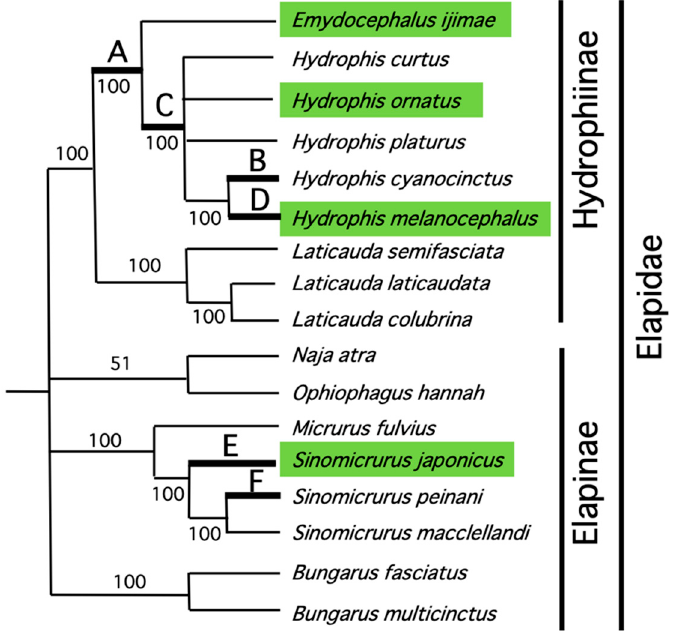
Figure 4. Timing of changes in mtDNA structural features in Elapidae. On a strict consensus tree between the ML trees constructed using nucleotide and amino acid sequences (see Figures S6 and S7, respectively), the ( A – F ) symbols indicate branches where changes in mtDNA features probably occurred as inferred by the maximum-parsimony criterion in change numbers. These changes are: ( A ), translocation of O L from between tRNA Asn and tRNA Cys genes to between tRNA Ala and tRNA Asn genes; ( B ), reversal of the O L translocation from between tRNA Ala and tRNA Asn genes to between tRNA Asn and tRNA Cys genes; ( C ), loss of the control region from MNCR2; ( D ), duplication of the control region within MNCR1; and ( E , F ), independent insertions of long tandem repeats between tRNA Cys and tRNA Tyr genes. Numbers on branches represent bootstrap probabilities on the ML tree constructed using nucleotide sequences (Figure S6). Species highlighted in green represent the four species sequenced in this